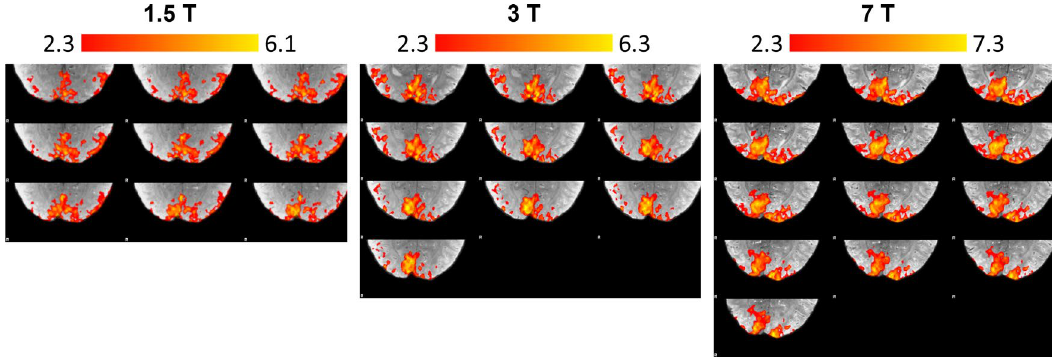
Figure 1. Exemplary activation maps obtained for the same subject at the three different static magnetic field strengths used. Significantly activated voxels are shown in colour. Those in primary visual cortex were used as a mask to extract activation